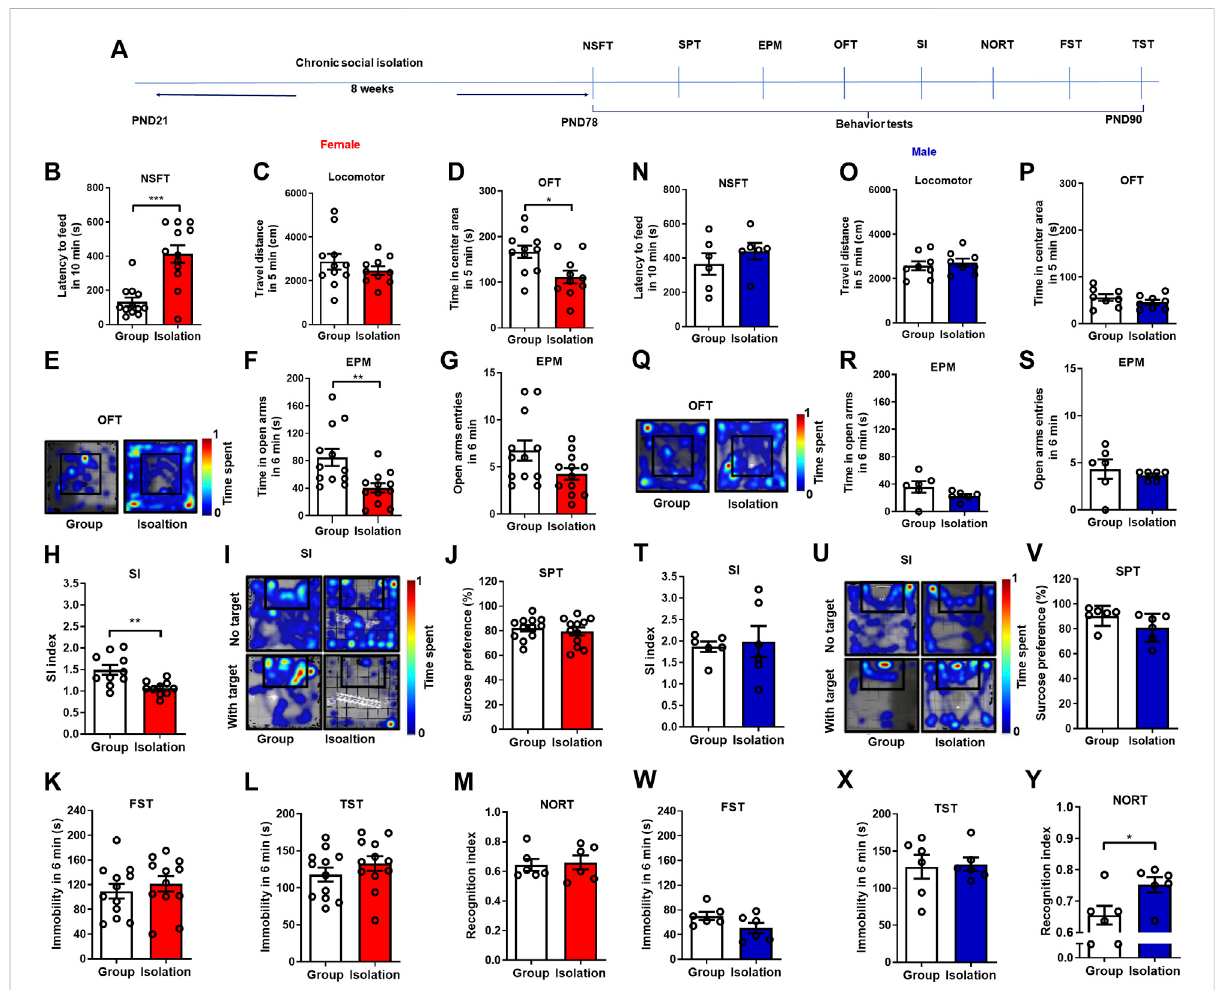
FIGURE 1 Chronicsocialisolationinducedanxiety-likebehaviorsinfemalebutnotmalemice. (A) Timelineoftheexperimentalprocedure. (B) Thenovelty suppressed feeding test in female mice (red bars, n = 10 – 12). (C) The locomotor test. (D,E) Time spent in the center area and representative heat mapsduringopen fi eldtest. (F,G) Timeandentriesintheopenarmsintheelevatedplusmazetest. (H,I) Thesocialinteractiontestandrepresentative heat maps. (J) The sucrose preference test. (K) The forced swim test. (L) The tail suspension test. (M) The novel object recognition test. (N) The noveltysuppressedfeedingtestinmalemice(bluebars, n =6 – 8). (O) Thelocomotortest. (P,Q) Timespentinthecenterareaandrepresentativeheat mapsduringopen fi eldtest. (R,S) Timeandentriesintheopenarmsintheelevatedplusmazetest. (T,U) Thesocialinteractiontestandrepresentative heat maps. (V) The sucrose preference test. (W) The forced swim test. (X) The tail suspension test. (Y) The novel object recognition test. Data